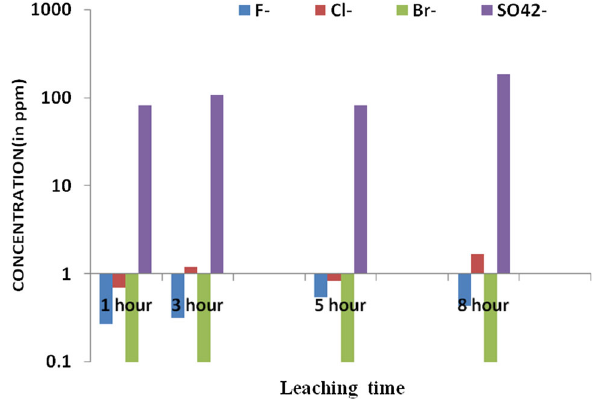
Fig. 18 Change in concentration (in ppm) of anions in aqueous leachates of Ledo overburden (LOB-15B) with leaching time (in hour) at 45 (cid:3)